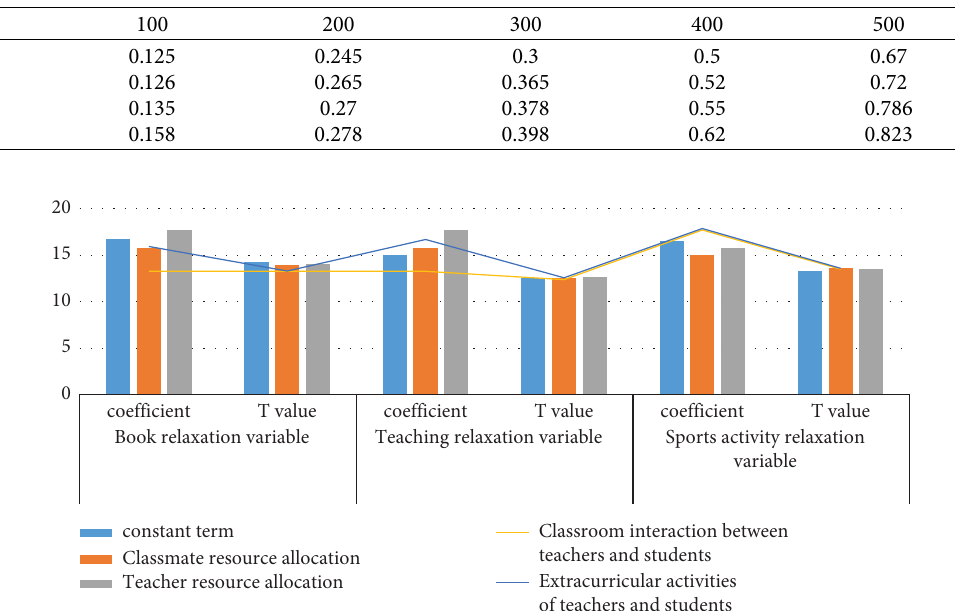
Figure 7: Proportion of resource collection and